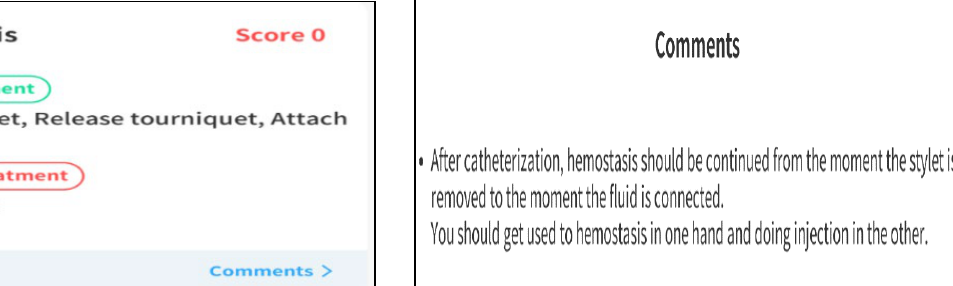
Figure 4. Attention alarm during VRS for IV injection.